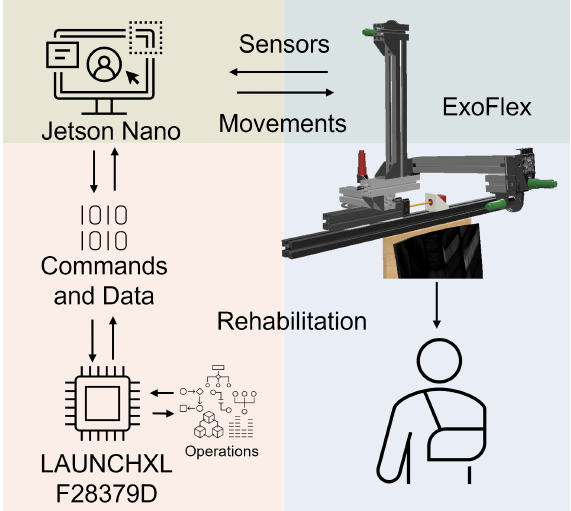
Figure 2. System architecture. Electronics, actuators and